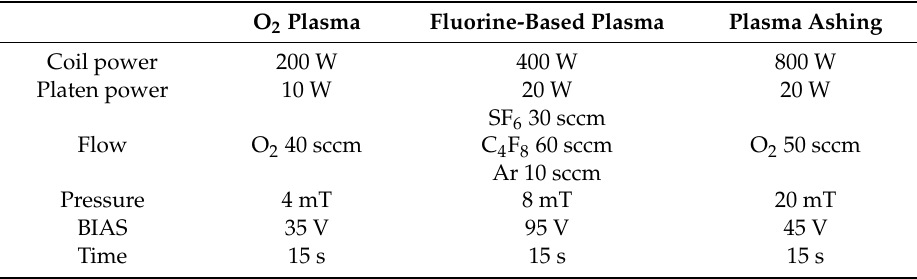
Table 1. Inductive coupled plasma (ICP) parameters used in the fabrication of the stamp: for the removal of residual layer after the thermal nanoimprint lithography (TNIL) process, for the pattern transfer into silicon, and for the ashing for the final resist